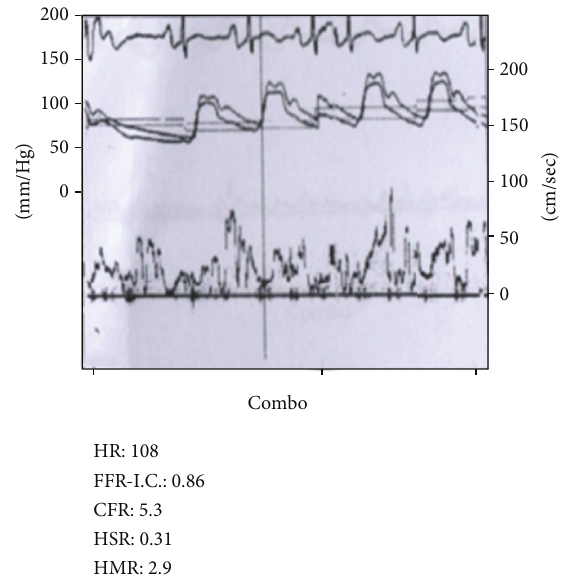
Figure 4: Coronary flow reserve (CFR) tracing during 140mcg/kg/ min intravenous adenosine infusion following side branch balloon occlusion revealing a value of 5.3.